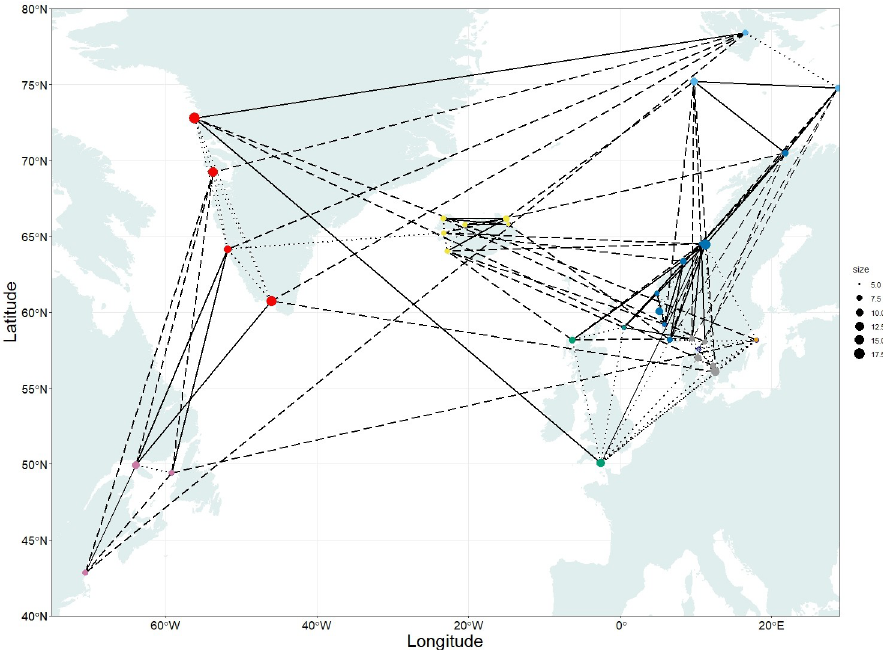
Fig 5. Population graph representing the distribution of genetic covariance in the global lumpfish ( Cyclopterus lumpus ) population based on 139 SNPs. Nodes represent samples, and their relative sizes the amount of within- population genetic variance. Edges connecting the nodes represent the pattern of genetic covariance among populations: Dashed lines denote extended edges (i.e., more gene-flow than what would be expected given geographic distance), dotted lines compressed edges, (i.e., less gene-flow than what would be expected given geographic distance), and continuous line proportional edges (i.e., not significantly more or less gene-flow). Colors indicate geographic regions as described in Table 1.